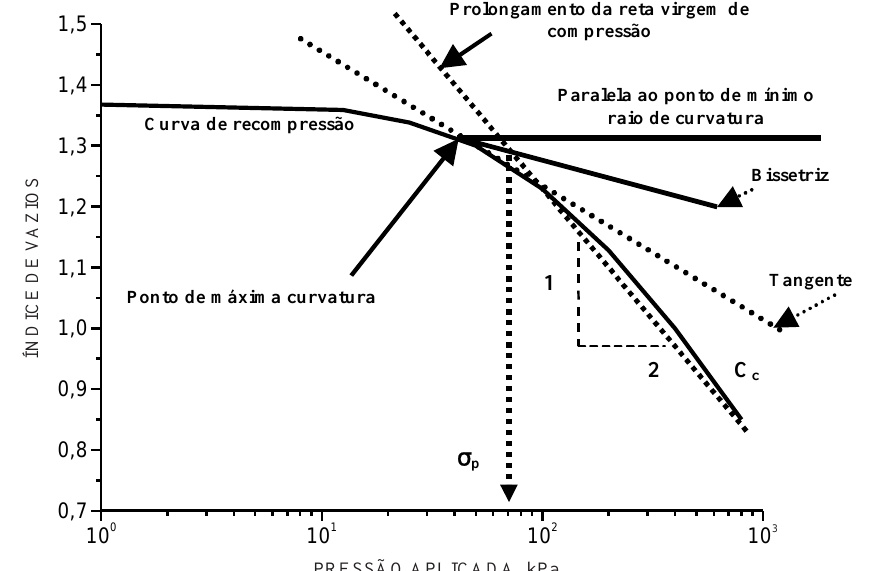
Figura 1. Esquema ilustrativo da determinação da pressão de preconsolidação e do índice de compressão, obtidos da curva de compressão, método de